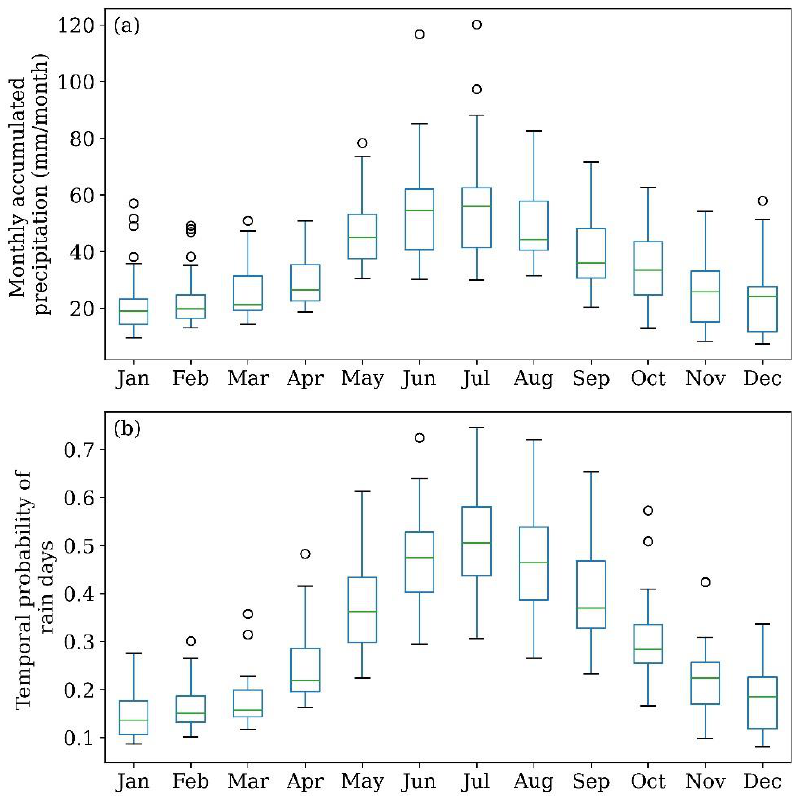
Figure 2. Box–whisker plots of 1901 to 2018 averaged ( a ) monthly accumulated precipitation (mm / month) across the Australian wheatbelt (see Figure 1) and ( b ) monthly probability of rain days (bottom). For both parts, the horizontal line represents the median of the data, the box spans from 25th to 75th quartiles of the data, and the circles past the end of the whiskers are outliers, while the rain day threshold is 0 mm /